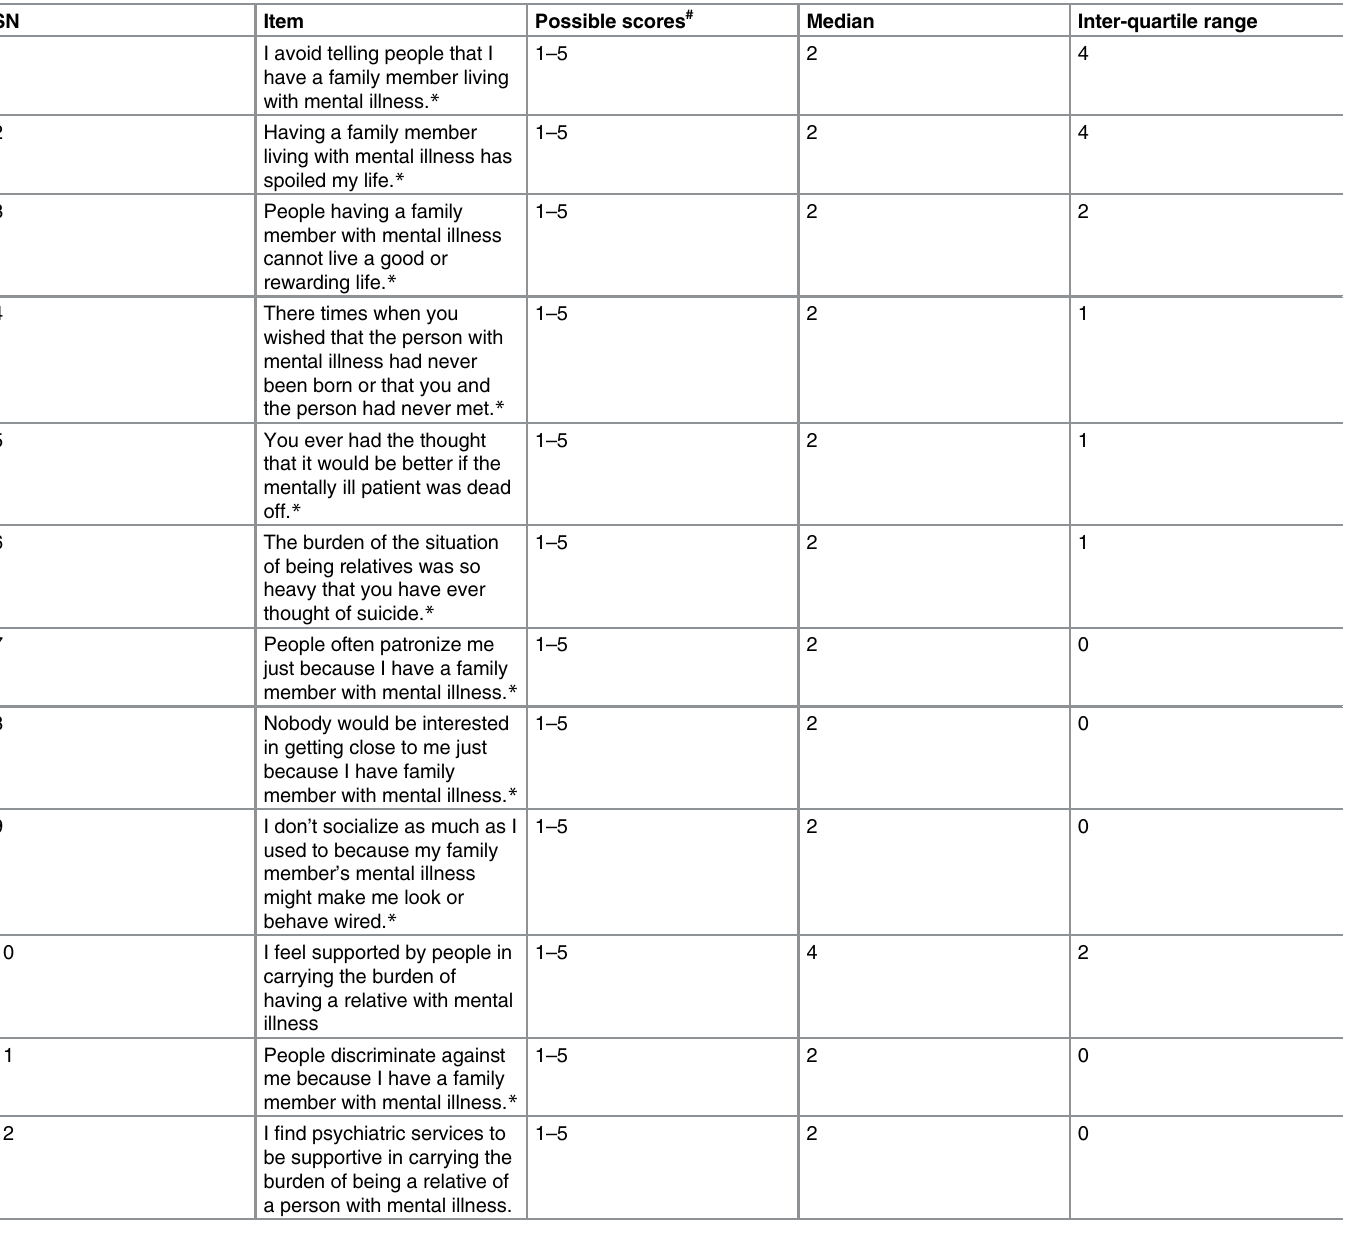
Table 3. Median score of items measuring perceived